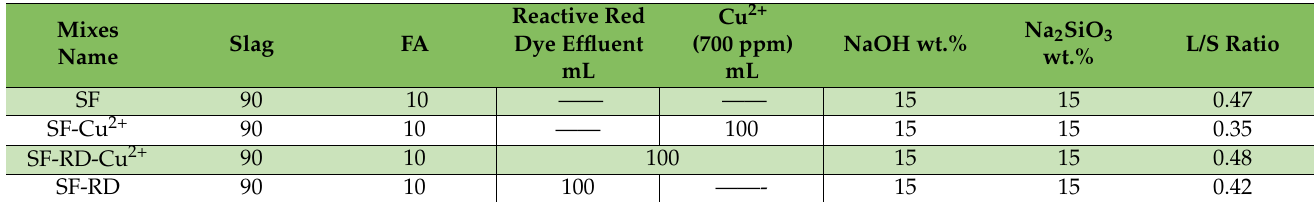
Table 3. Mix composition of the examined mixture and liquid/solid (L/S)